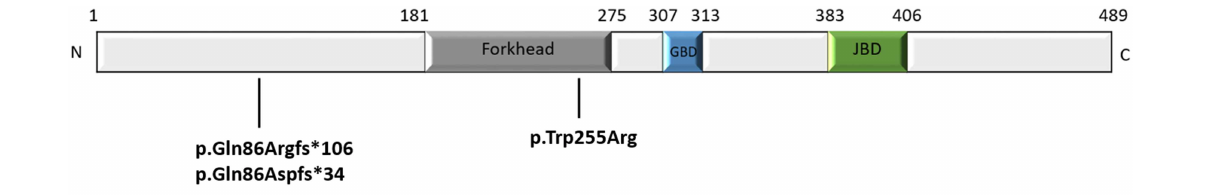
FIGURE 1 | Schematic representation of the FOXG1 protein (consisting of 489 amino acid) and the mutations of our patients. The N-terminal domain, fork-head domain, the Groucho-binding domain (GBD), the JARID1B binding domain (JBD), and C-terminal domain of FOXG1 are shown.